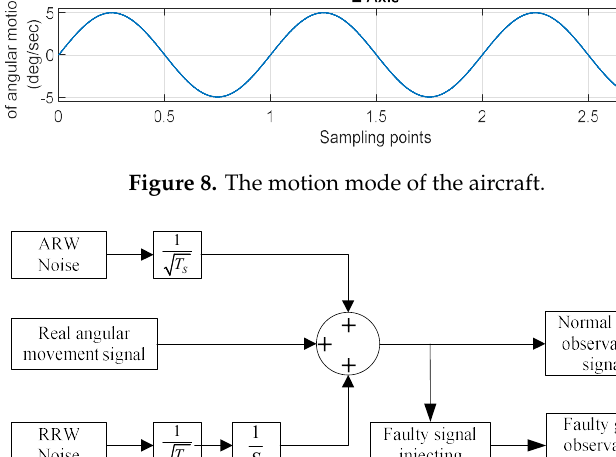
Figure 9. The signal generator of a single gyro.